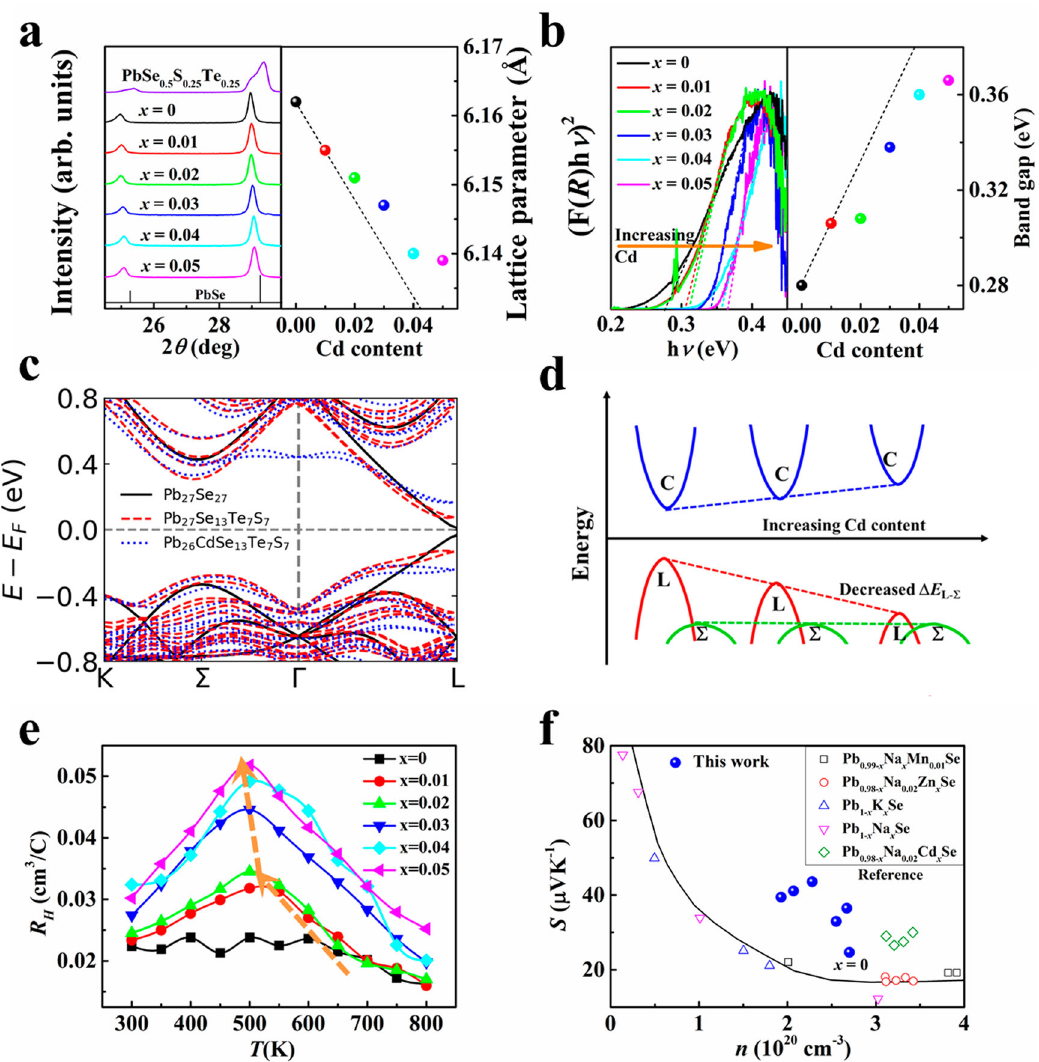
Fig. 2 Band convergence in p-type Cd-doped chalcogenides. a Powder XRD patterns (left), calculated lattice parameters (right), b room-temperature infrared diffuse re fl ectance spectroscopy (left) and calculated band gaps (right) for Pb 0.975 − x Cd x Na 0.025 Se 0.5 S 0.25 Te 0.25 ( x = 0, 0.01, 0.02, 0.03, 0.04, 0.05) samples. The spheres with different colors correspond to the lines with the same colors. c Calculated band structures of Pb 27 Se 27 , Pb 27 Se 13 Te 7 S 7 , and Pb 26 CdSe 13 Te 7 S 7 . d Schematic diagram of band convergence by alloying S, Te, and Cd in PbSe. e Temperature dependence of Hall coef fi cients (the orange arrows represent the decreased peak temperature), and f carrier concentration dependence of the Seebeck coef fi cients (the Pisarenko relationship) for Pb 0.975 − x Cd x Na 0.025 Se 0.5 S 0.25 Te 0.25 ( x = 0, 0.01, 0.02, 0.03, 0.04, 0.05) samples (blue spheres). The black line and open symbols are from reference 27